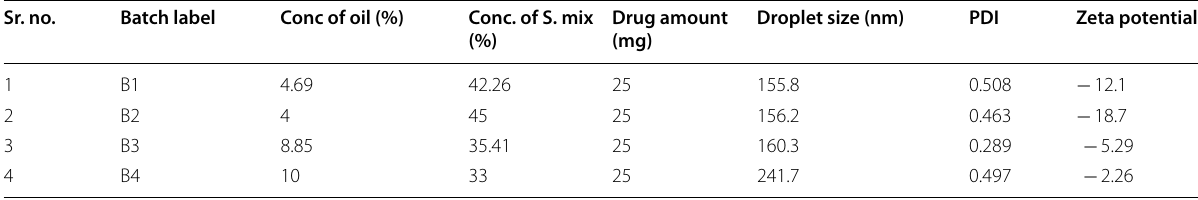
Table 3 Evaluation of nanoemulsion Sr. no.